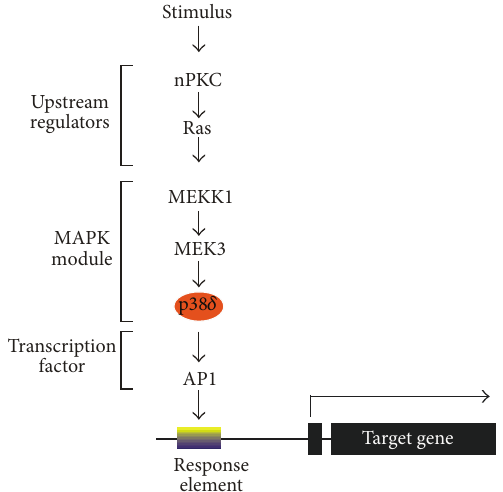
Figure 1: MAPK and AP1 transcription factor control of gene expression. The p38 𝛿 MAPK cascade that controls the expression of differentiation-associated genes in epidermis is depicted [10]. The three kinases of the MAPK module include MEKK1, MEK3, and p38 𝛿 MAPK. A differentiation stimulus activates upstream regula- tory proteins, in this case novel protein kinase c (nPKC) and the Ras small GTPase. These events lead to phosphorylation and activation of MEKK1 which phosphorylates MEK3 which phosphorylates p38 𝛿 MAPK. Ultimately p38 𝛿 MAPK increases AP1 transcription factor expression and activity and the AP1 transcription factors bind to the response element on the target gene promoter to increase